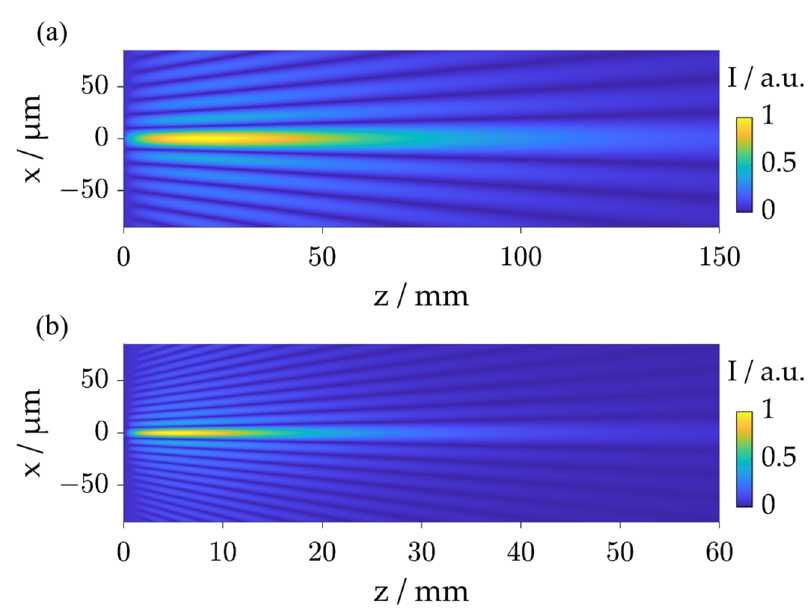
Figure 3. Simulated intensity distribution of the Bessel beam in propagation direction behind the axicon ( a ) and lens 3 ( b ).